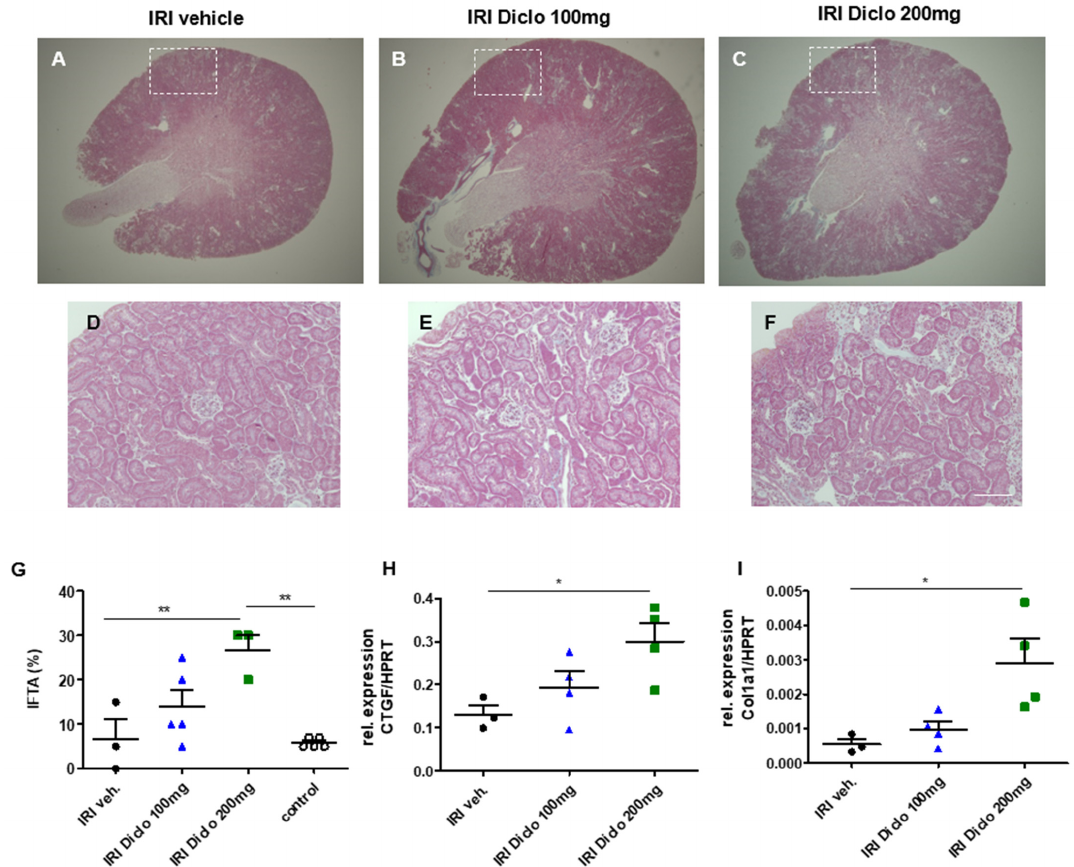
Figure 2. Chronic renal damage two weeks after renal ischemia–reperfusion injury (IRI) and di- clofenac treatment. Masson trichrome-stained whole kidney sections of IRI mice treated with ve- hicle ( A ), or a single oral dose of 100 mg diclofenac ( B ) or 200 mg diclofenac ( C ) are shown. Inter- stitial fibrosis and tubular atrophy (IFTA) were scored in the renal cortex (white square, A – C ). A single oral dose of 200 mg diclofenac in the setting of subclinical AKI caused enhanced IFTA after two weeks ( D – G ). Already 24 h after IRI, the pro-fibrotic markers, CTGF and collagen 1a1 (col1a1), were significantly elevated in the renal tissue in mice treated with a single dose of 200 mg diclo- fenac ( H , I ). In the IRI groups, n = 3–5 mice are shown. * p < 0.05, ** p < 0.01, Scale bar 100 μ m. 3.2.2. Pro-fibrotic Cytokines in the Renal Tissue 24 h after IRI To investigate whether there are early indicators for the development of chronic renal damage, the pro-fibrotic markers CTGF and collagen 1 alpha 1 (coll1a1) were measured in the renal tissue 24 h after renal IRI and vehicle or a single dose of diclofenac treatment, respectively. A single dose of 200 mg, but not 100 mg, of diclofenac caused increased renal tissue expression of the pro-fibrotic markers CTGF (Figure 2H) and col1a1 (Figure 2I) 24h after renal IRI.